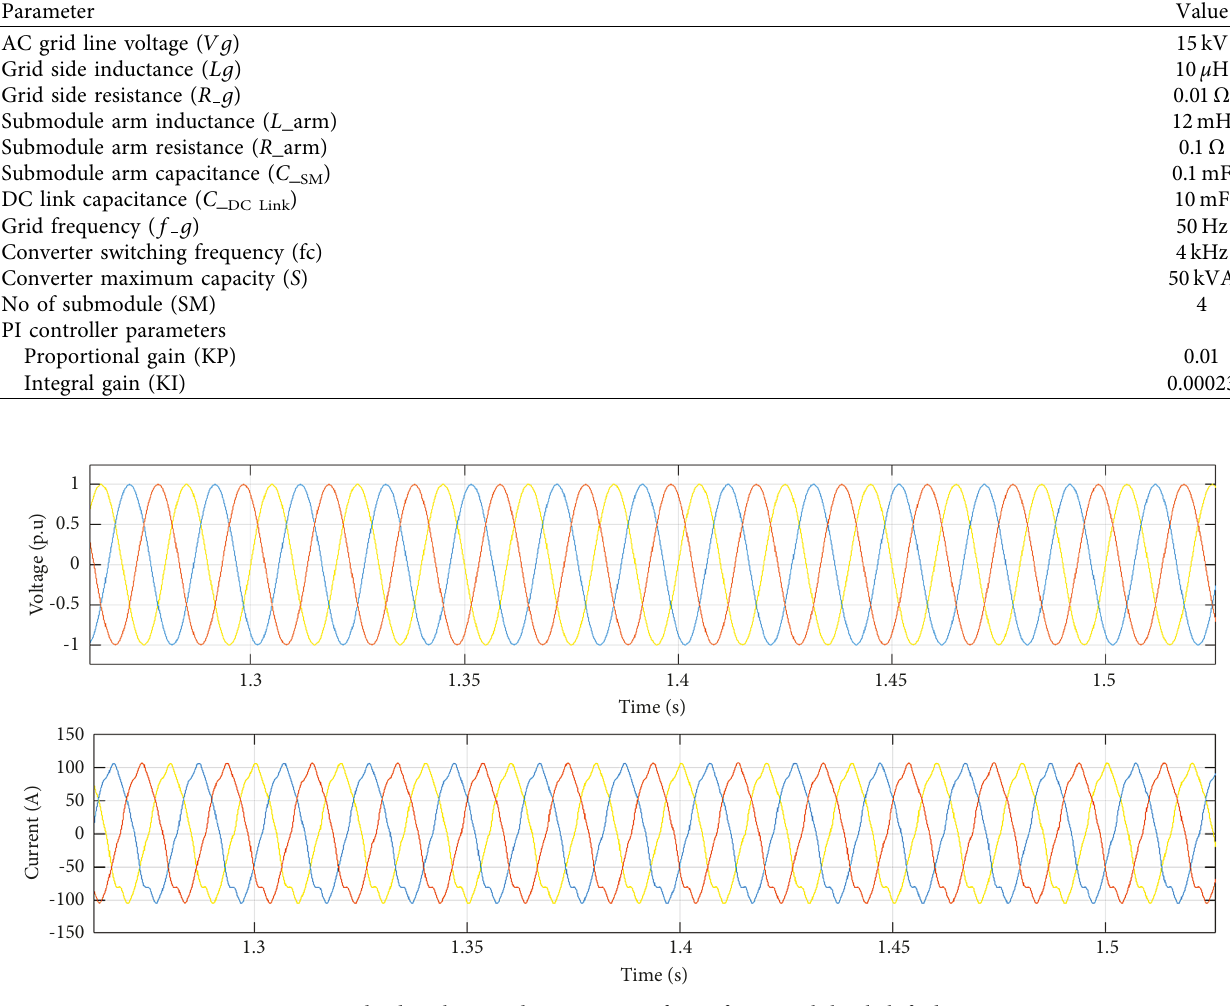
Figure 6: Grid side voltage and current wave forms for PI with level-shifted PWM.